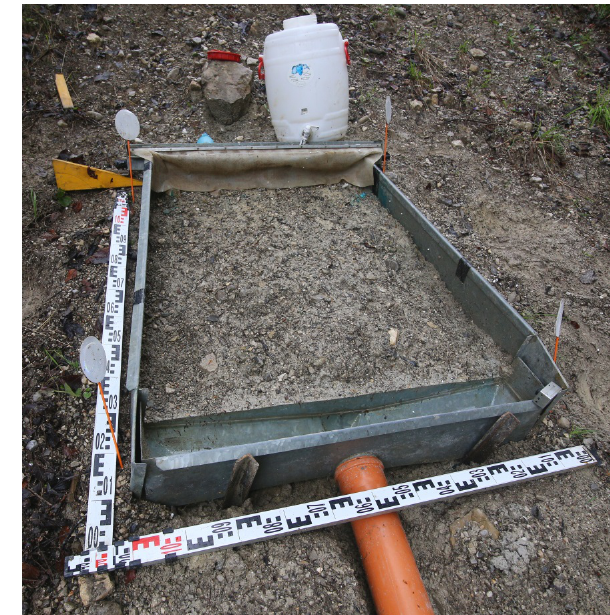
Figure 1. Experimental setup including plot, 30L barrel, runoff collector, reflectors for tachymeter registration and measuring stick for scaling purposes.